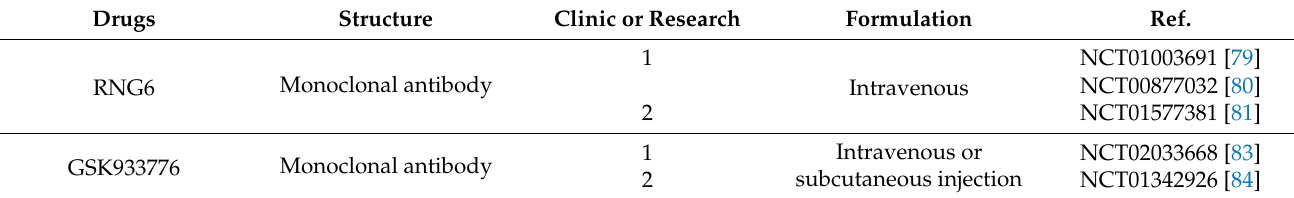
Table 2. Drugs targeting β